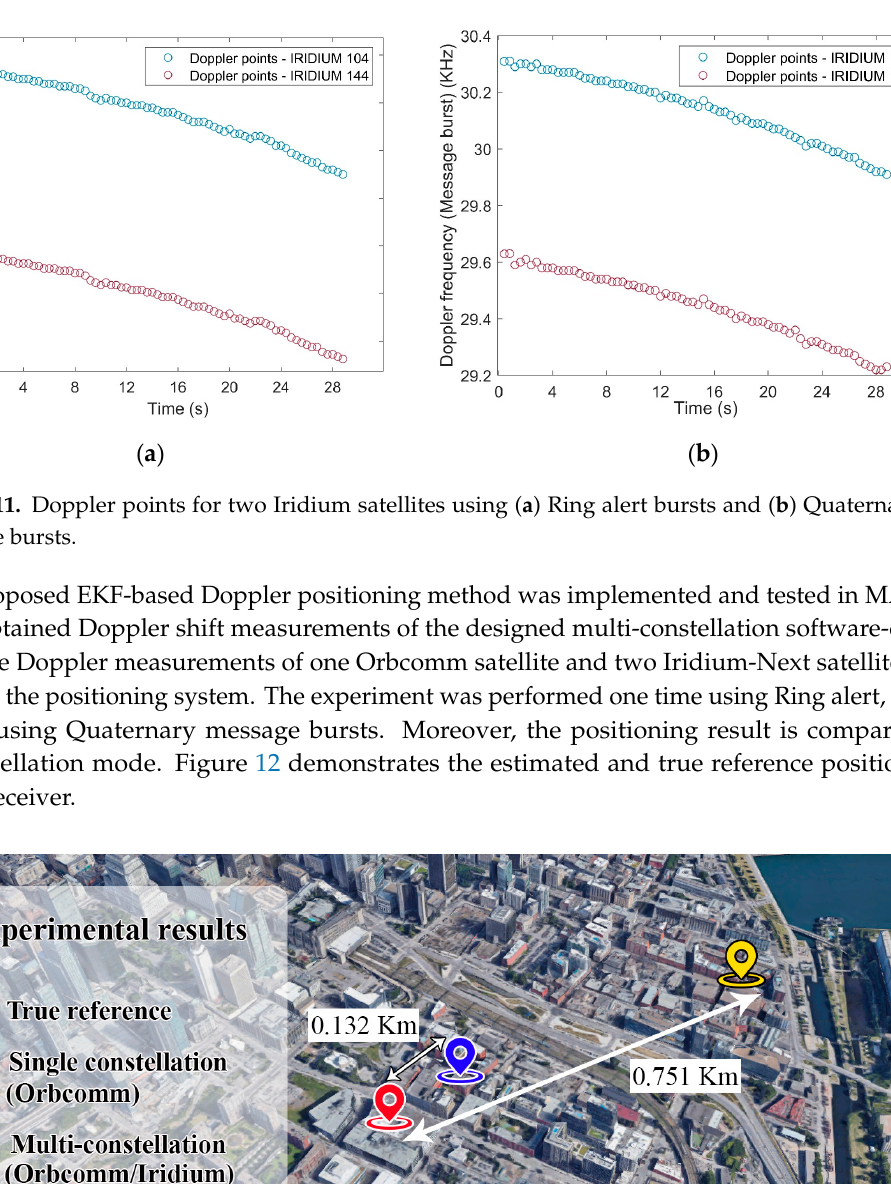
12 of 17 Figure 10. Doppler shift tracking for Orbcomm FM110 in 30 s measurements. Also, Figure 11 demonstrates the extracted Doppler shift points from Iridium’s simplex bursts. The duration of each simplex signal was 90 ms [30], so approximately 72 Doppler points were